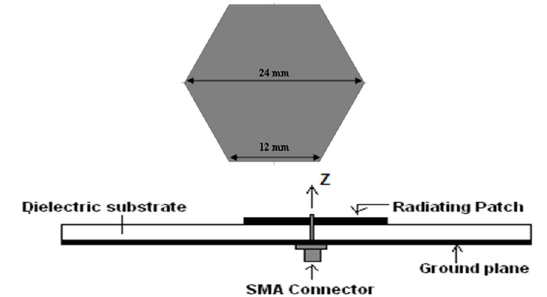
Figure 1. Top and side view of simple hexagonal geometry.